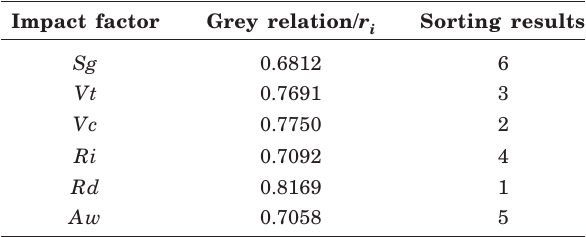
Table 4. Grey relational analysis